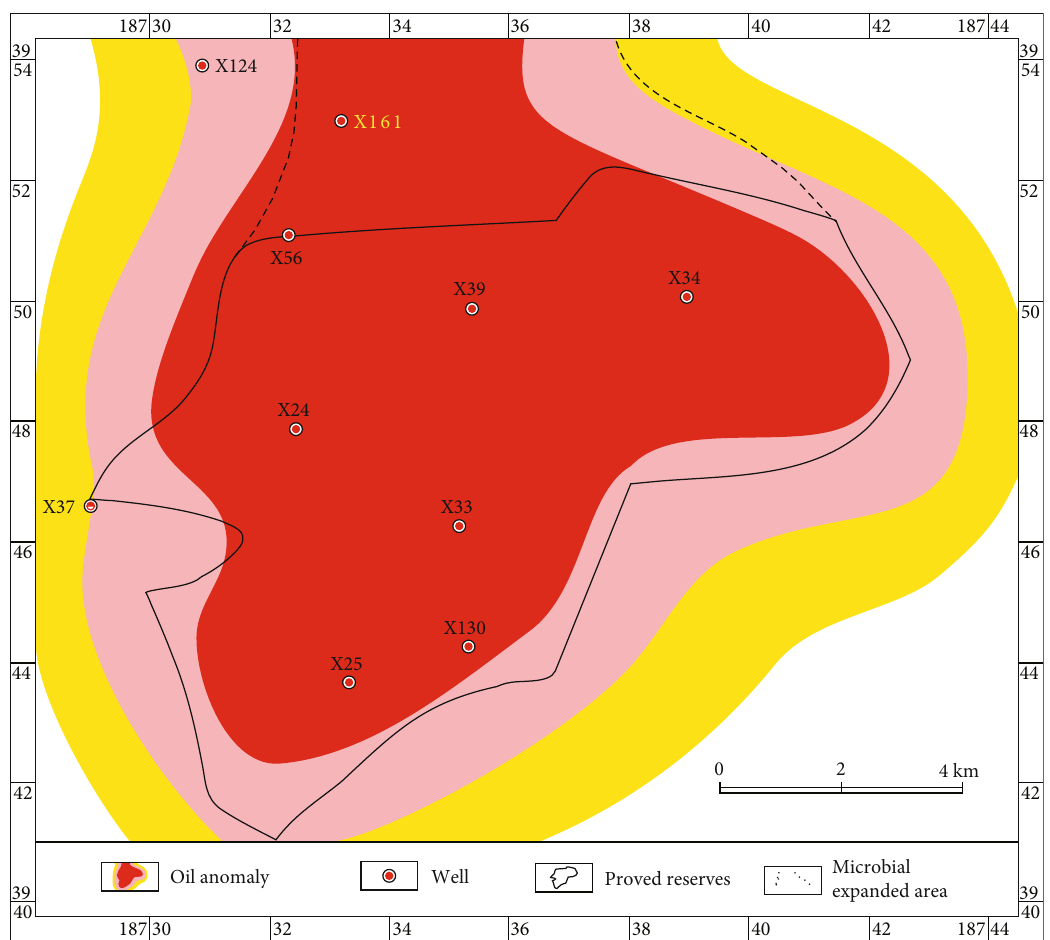
Figure 4: Anomalous characteristics of reservoir microorganisms in Dongzhiyuan block, Xifeng Oil fi eld,